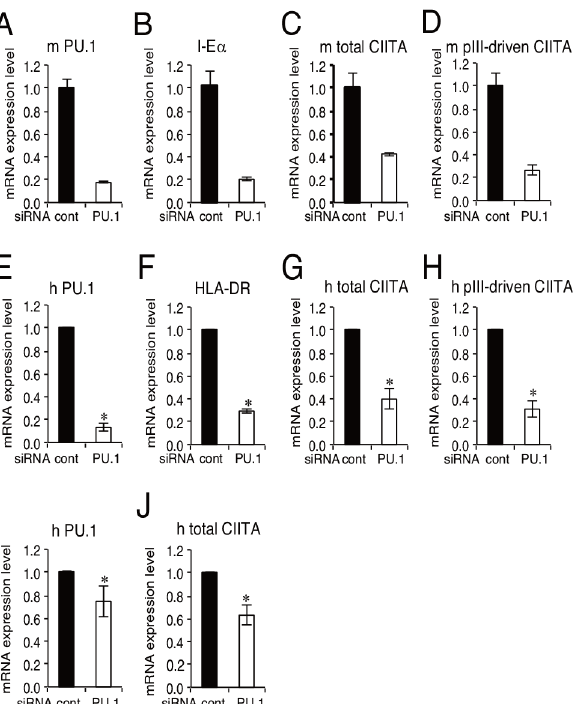
Fig 1. Effect of PU.1 knockdown by siRNA on the mRNA levels of CIITA and MHC class II in mouse pDCs and human pDC cell line. The mRNA expression levels of PU.1 (A, E), MHC class II (B, F), CIITA (C, G), and CIITA specifically driven from pIII (D, H) in mouse PU.1 siRNA-introduced BMpDCs (A-D), or human PU.1 siRNA (Spi1-HSS186060)-introduced CAL-1 cells (E-H) are displayed as the ratio of mRNA levels versus those seen in control siRNA-introduced cells. The mRNA levels of PU.1 (I) and CIITA (J) in CAL-1 cells transfected with another PU.1 siRNA (Spi1-HSS144058) are also displayed. Cells were harvested at 24h (A-D) or 96h (E-J) after siRNA transfection. Open bar, PU.1 siRNA; closed bar, control siRNA. In E-J, data represent means ± SEMs of three independent experiments, and each experiment was performed with triplicate samples. In A-E, the results are expressed as means ± SEMs of triplicate samples, and similar result was obtained in another experiment. * , p <